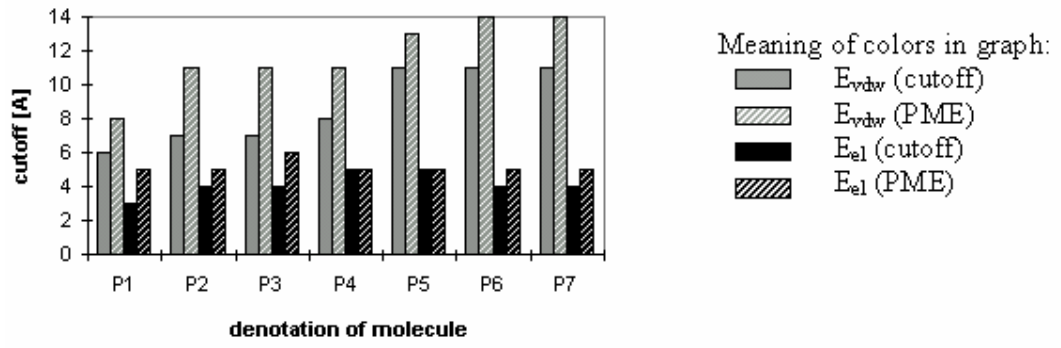
Figure 3. Smallest values of cutoff for which energy error is smaller then 1% (for peptides and